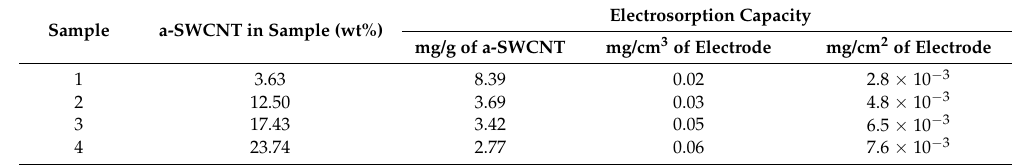
Table 1. Electrosorption capacity of various a-SWCNT-coated RVC electrodes.